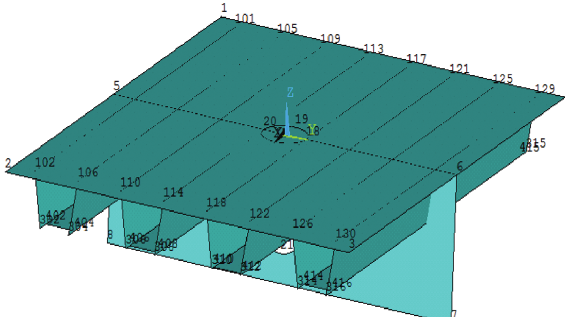
Figure 4: Three-dimensional FEM diagram of the initial model scheme of the solid